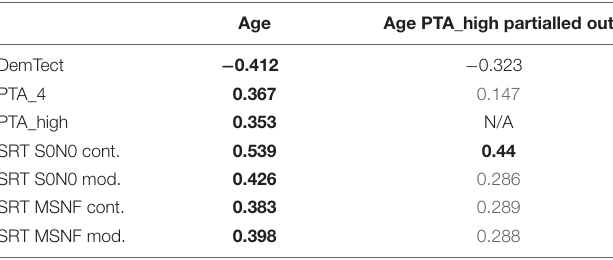
TABLE 1 | Spearman correlation coefficients ρ for results on measures of DemTect, hearing loss, and speech perception in noise vs. age (first column). Age Age PTA_high partialled out DemTect − 0.412 − 0.323 0.147 PTA_high 0.353